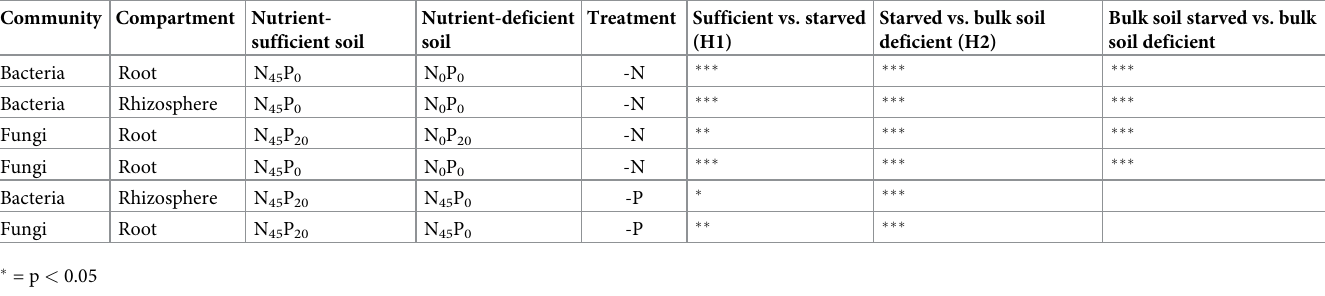
Table 1. Summary of tests that allowed the identification of starvation- and T . aestivum -specific communities. Community Compartment Nutrient- sufficient